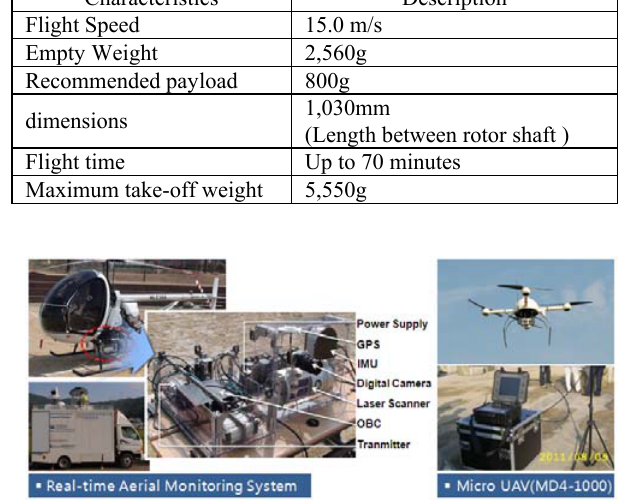
Figure 3. RAMS(left) and